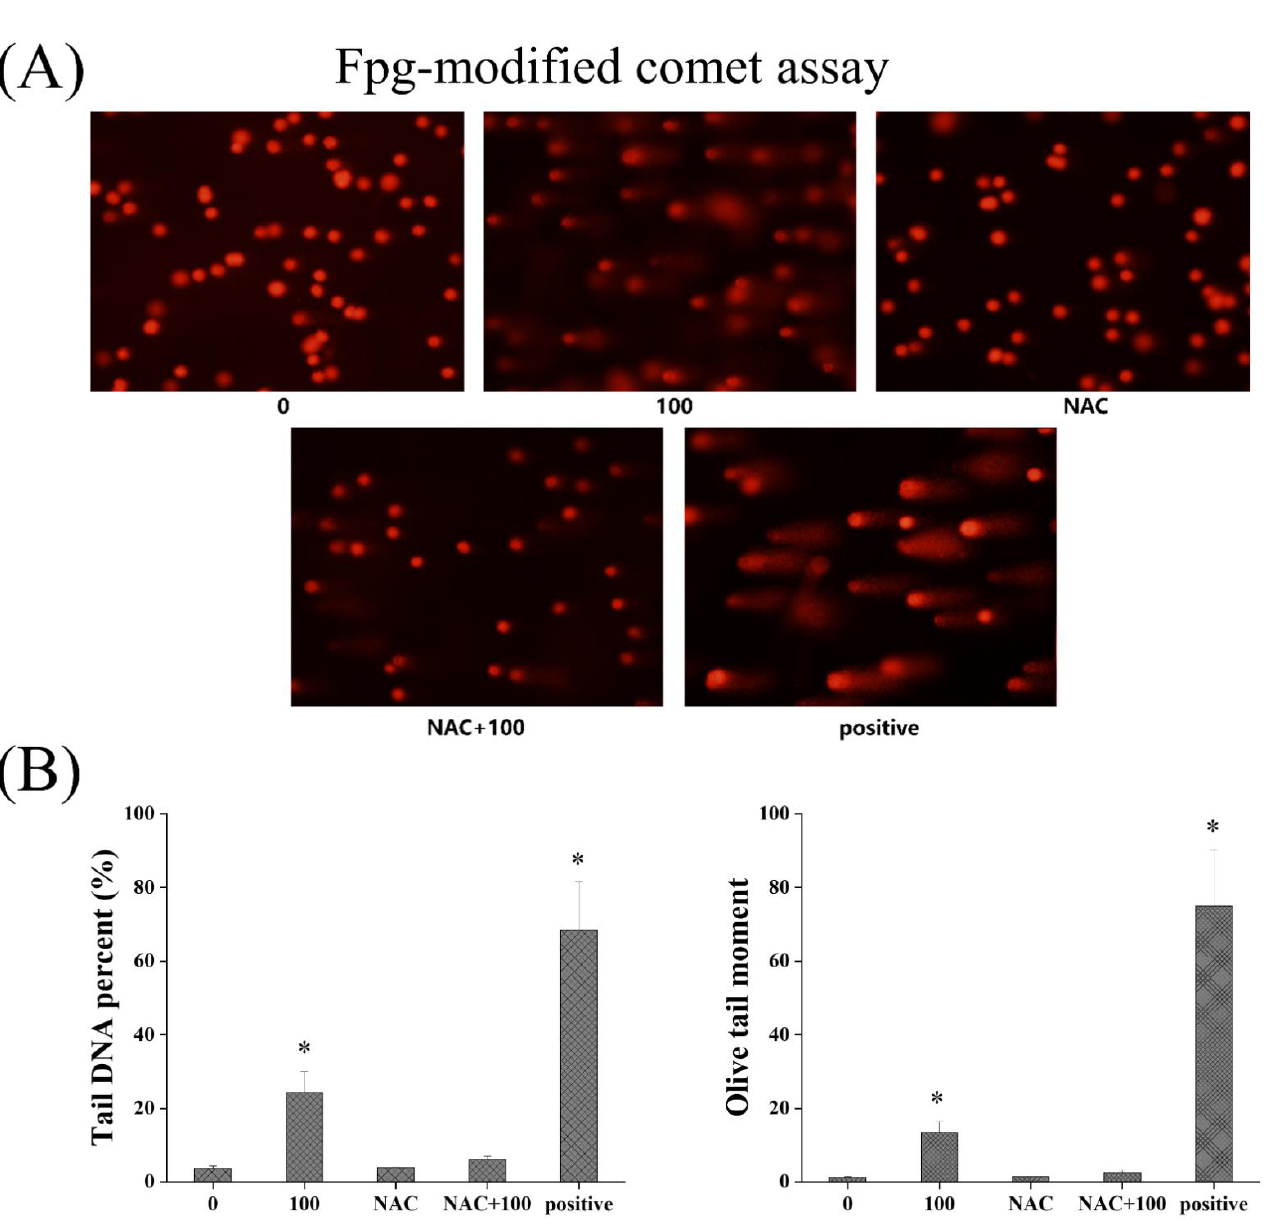
Figure 7. Effects of TiO 2 NPs on DNA damage in BEAS-2B cells after antioxidant intervention using the Fpg-modified comet assay ( A ). The DNA damage induced by TiO 2 NPs (100 µg/mL) was significantly recovered after NAC antioxidant intervention. Significant difference from the control (* p < 0.05) ( B ).